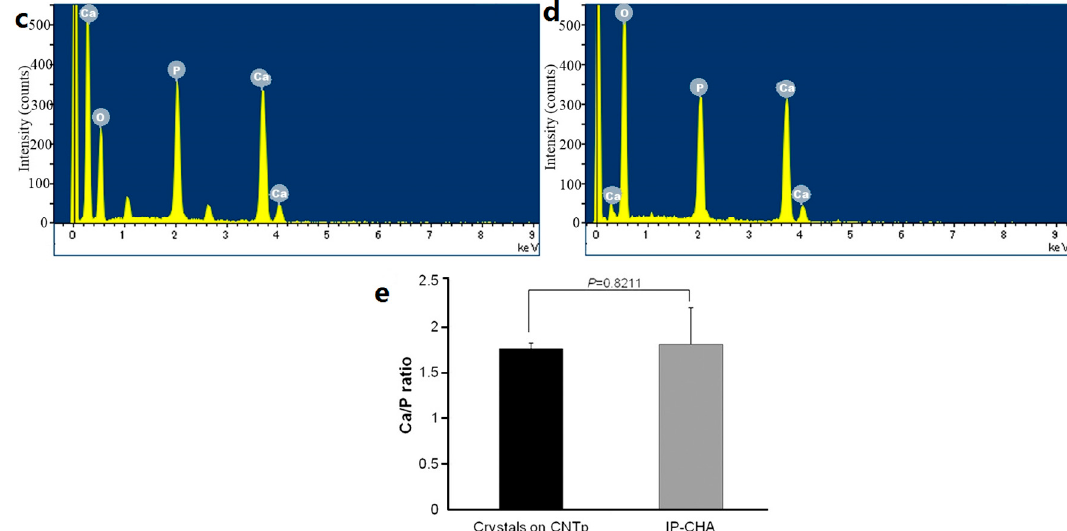
Figure 3. ( a ) SEM image of hydroxyapatite ‐ like crystal formation on CNTp scaffolds; ( b ) SEM image of a non ‐ treated IP ‐ CHA; ( c , d ) EDS on marked area revealed Ca, P, O in the crystal on ( c ) CNTp and ( d ) the surface of non ‐ treated IP ‐ CHA; ( e ) Ca/P ratio of the crystals appeared on the surface of CNTp and IP ‐ CHA. Mean values were compared using Student ʹ s t test ( n = 5).